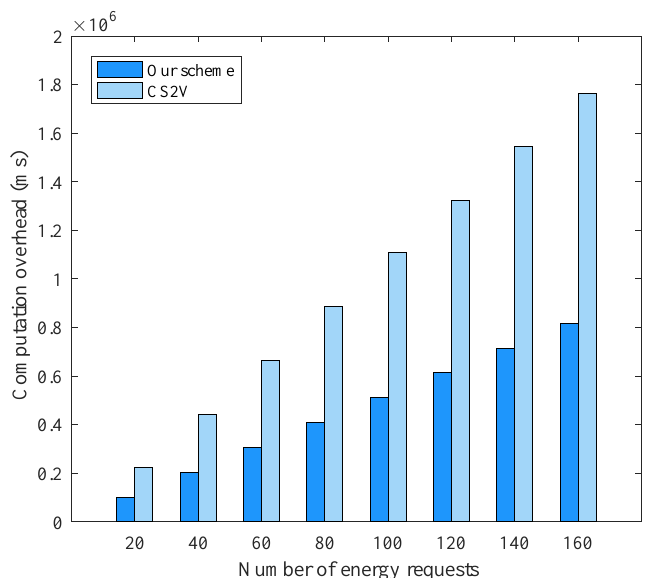
Figure 9. Computation overhead comparison with CS2V